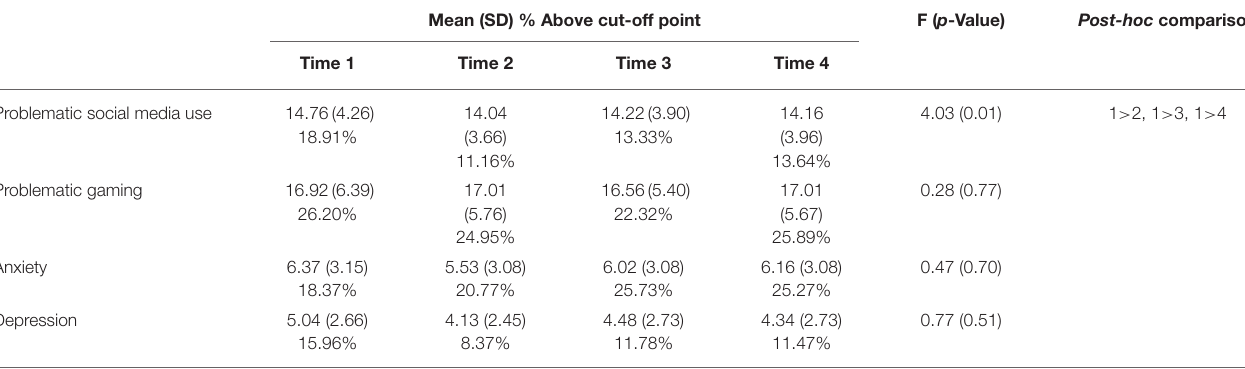
TABLE 2 | Problematic social media use, problematic gaming, anxiety, and depression across time. Mean (SD) % Above cut-off